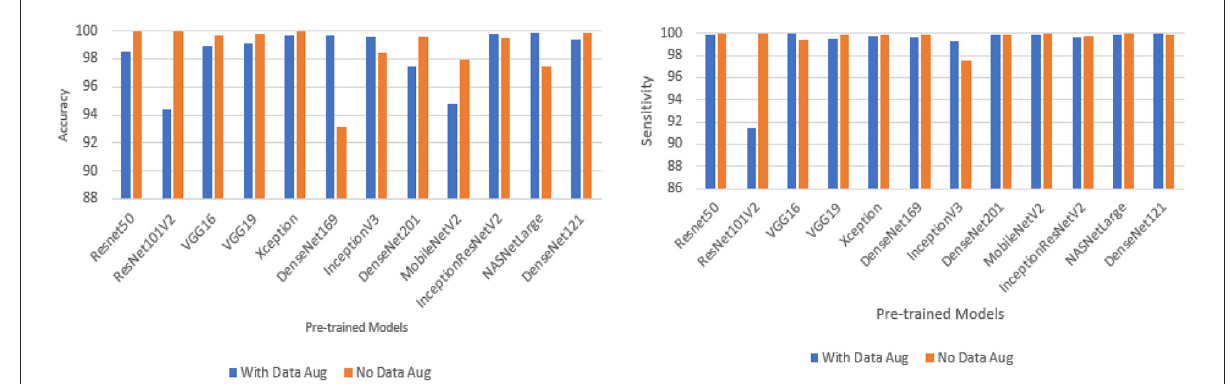
FIGURE5 Comparison between models with data augmentation and models without data augmentation.